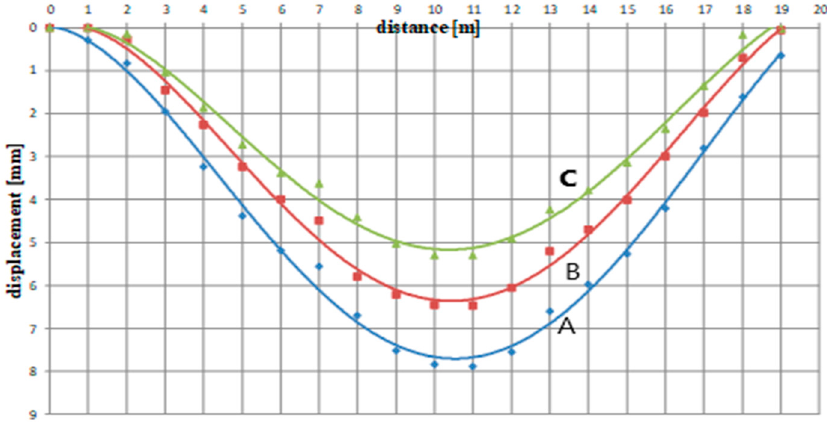
Figure 12. Crane beam deflection during the crane crab passage.